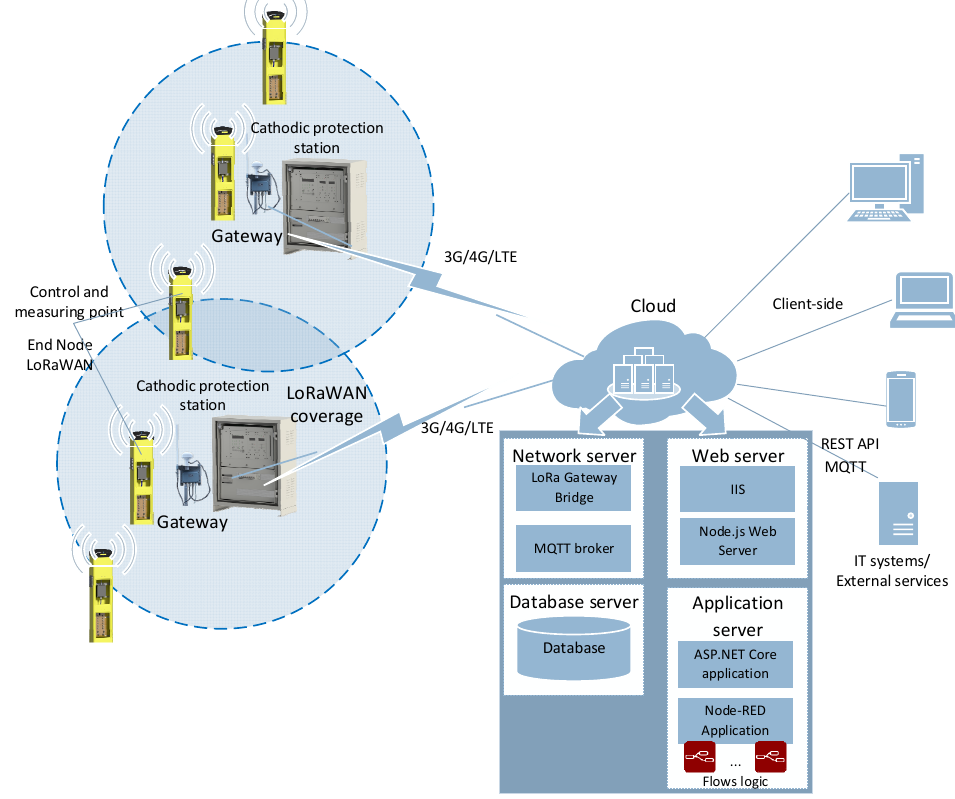
Figure 1. The structure of the distributed EChP system and the server software for the adaptive intelligent control and management system of EChP. intelligent control and management system of